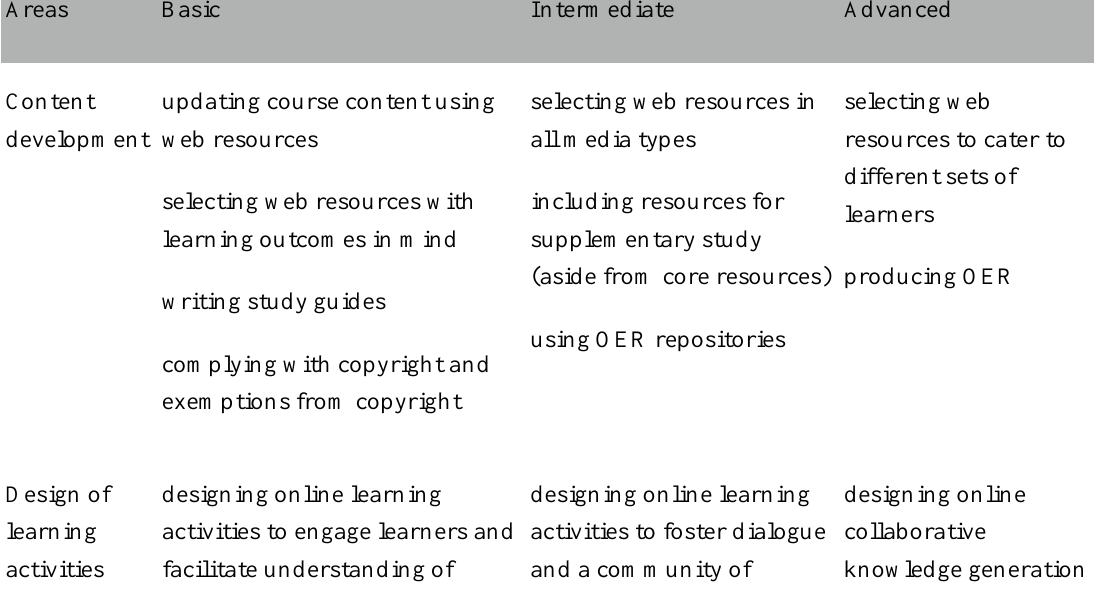
Proposed Framework of Developing ODeL Skills